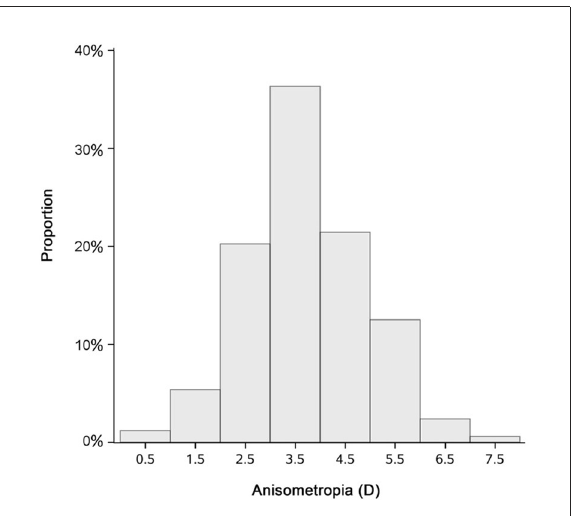
FIGURE3 Bar graph demonstrating the anisometropia of the 168 cases when vision deficit was resolved. ( − 0.18 to − 0.08; 95% CI) and − 0.20 ( − 0.27 to − 0.14; 95% CI),